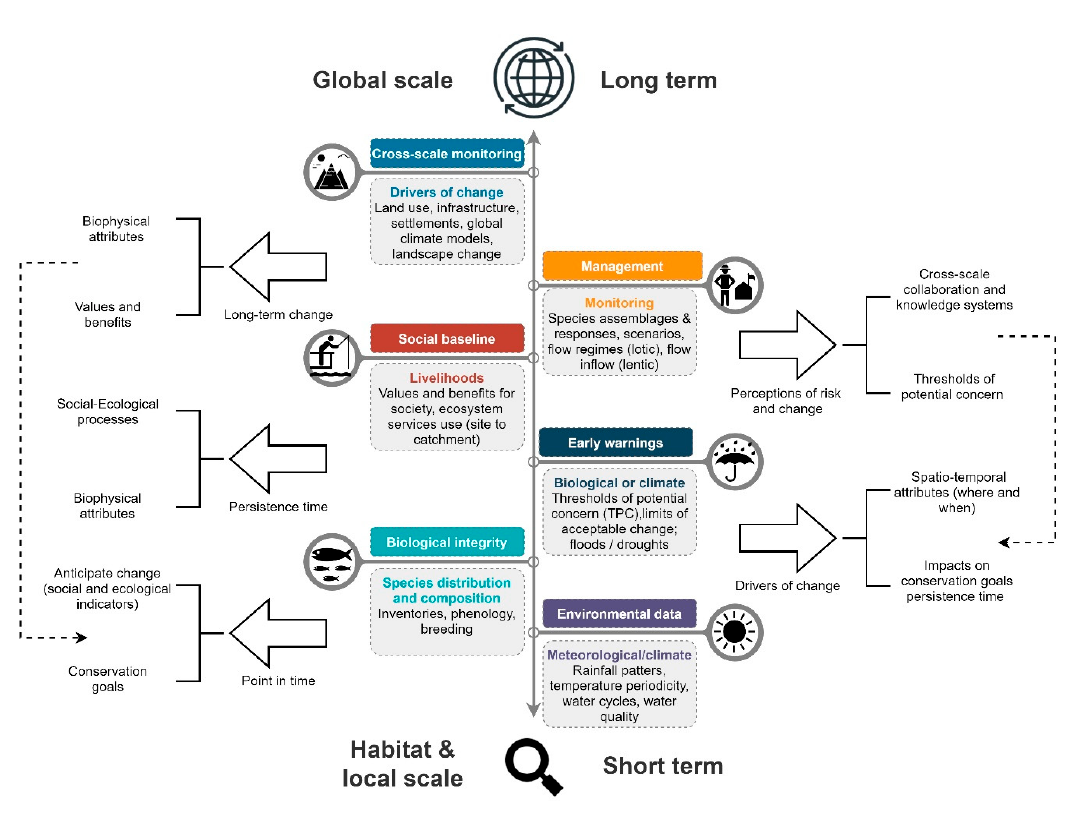
Figure 3. Overview of social-ecological processes and information needs on conservation goals for managing protected areas across spatio-temporal scales, from the short-term and local scale (bottom) to the long-term, large scale (top). Information from local level can help to understand conservation goals and social-ecological responses across scales, and the overall performance of ecological processes and functions. Data collected at the local scale (e.g., inventories) are limited to a moment in time and space; long-term monitoring can address temporal coverage from single inventories. Identifying early warnings like Thresholds of Potential Concern (TPC) facilitates an understanding of systems responses to drivers of change. Drivers of change can be events at local level/small temporal scales, or located at larger spatiotemporal scales, even outside the protected area, their impacts cascading across biophysical systems.